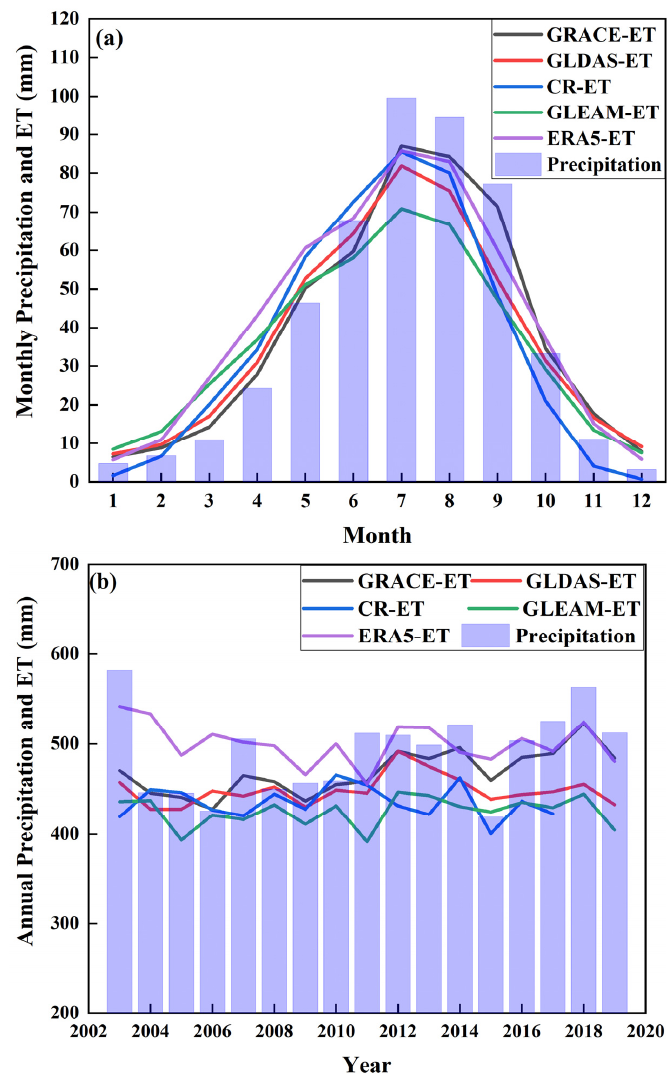
Figure 7. ( a ) Monthly mean and ( b ) annual cumulative evapotranspiration (ET) and precipitation in the Yellow River Basin. GRACE—Gravity Recovery and Climate Experiment; GLEAM—Global